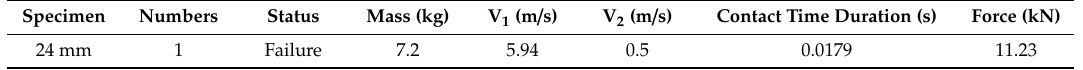
Table 5. The impact force of the benchmark fiber-reinforced cement specimen.